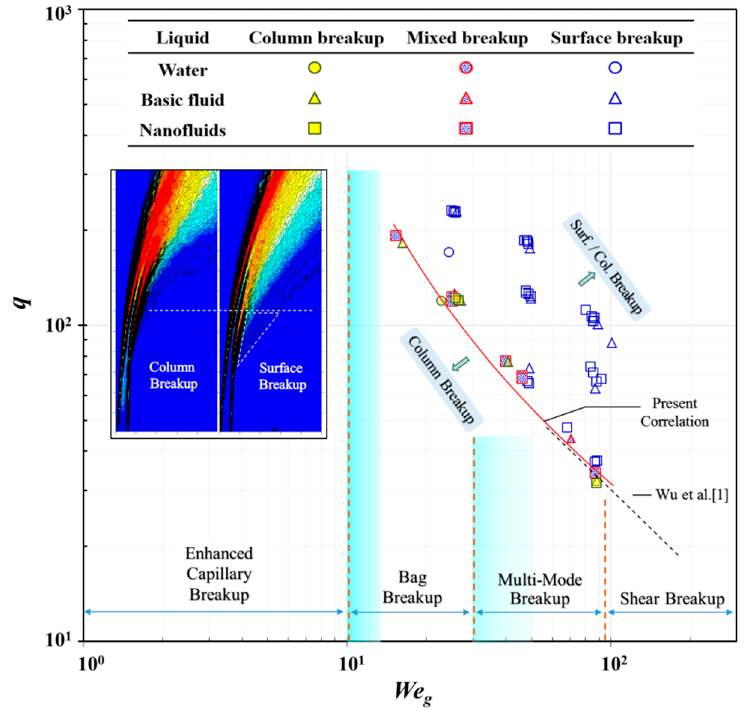
Figure 9. Primary breakup regimes plotted on the We g – q map.